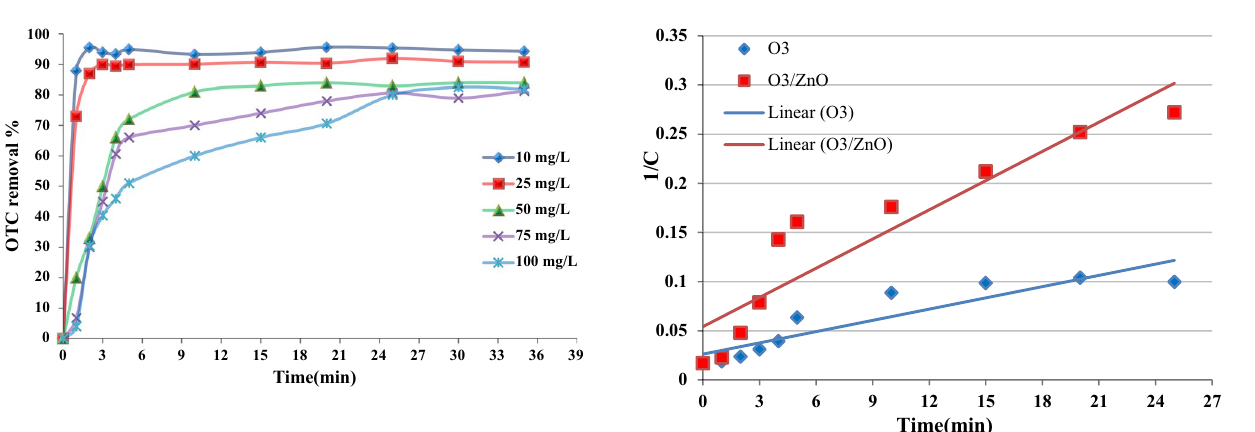
Fig. 11 Effect of the initial concentration OTC on the removal effi- ciency (pH = 7, ozone generation rate = 1.38 mg/s, at room temp)